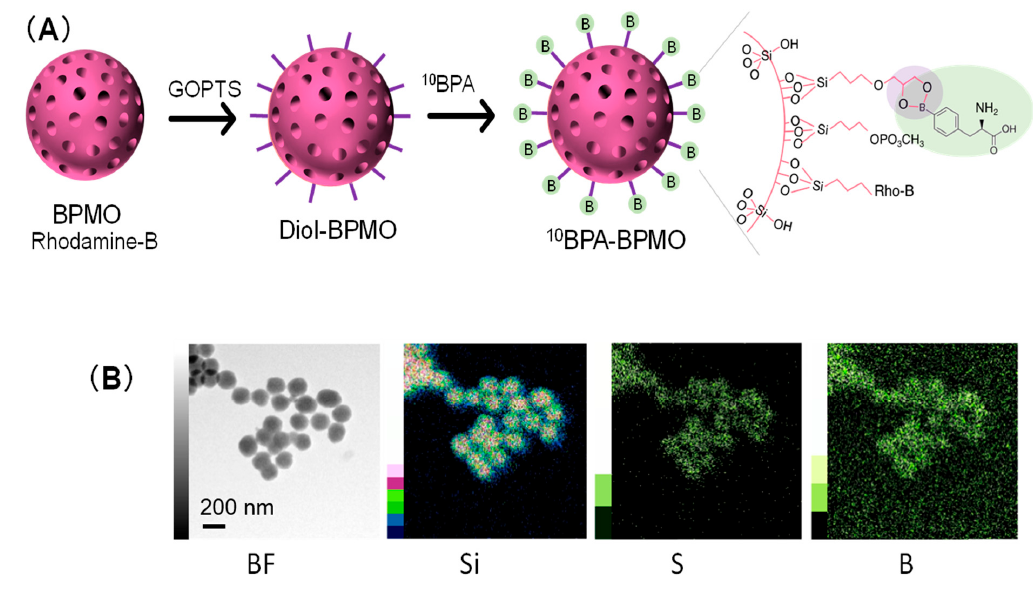
Figure 3. Loading of 10 BPA to BPMO. ( A) A strategy to load 10 BPA (highlighted in green) to BPMO nanoparticles; ( B ) EDX-TEM analysis of 10 BPA-loaded BPMO nanoparticles.